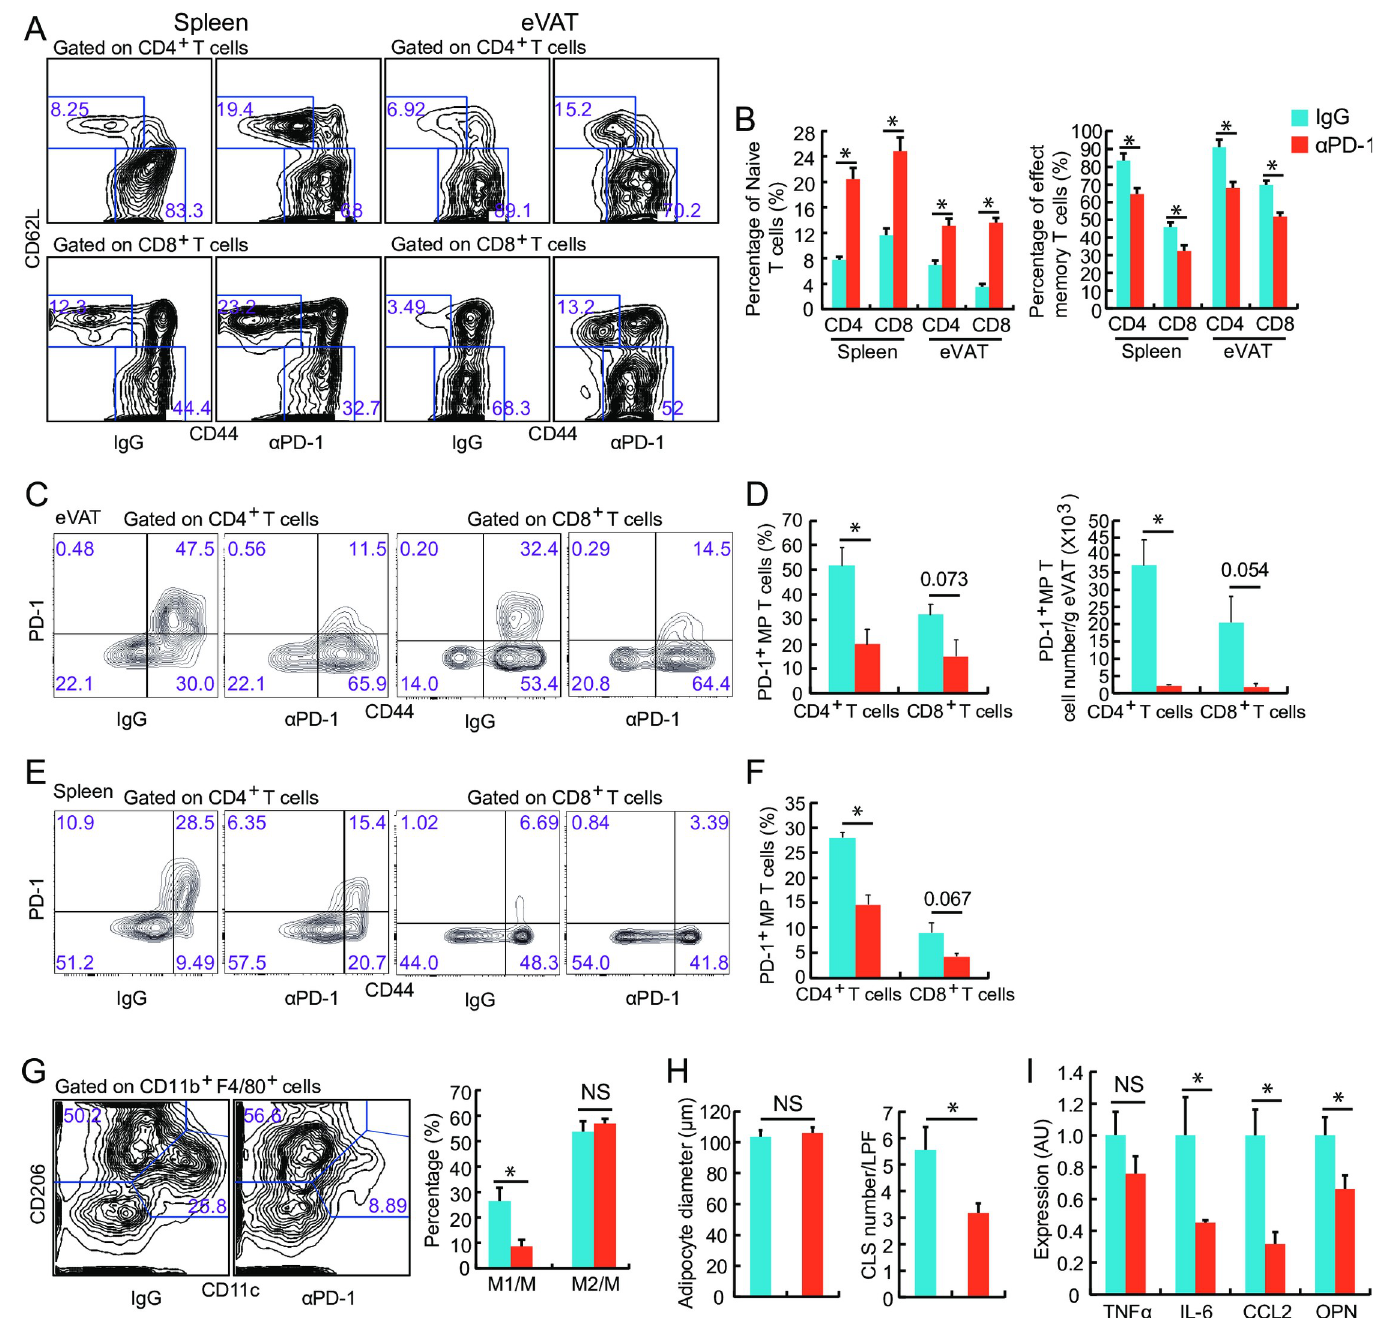
Fig 7. Effects of anti-PD-1 antibody treatment on adipose inflammation in aged mice. Either anti-mouse PD-1 antibody ( α PD-1) or control IgG (IgG) was administered three times per week for three weeks to 77-week-old mice. All examinations were performed when mice reached 80 weeks of age ( n = 4–8 mice in each group). ( A ) Flow cytometric analysis of CD44 - CD62L + T cells (na ï ve T cells) and CD44 + CD62L - T cells (MP T cells) was performed using spleen cells or eVAT of AL and CR mice. ( B ) The percentages of CD44 - CD62L + T cells and CD44 + CD62L - T cells. ( C , D ) Flow cytometric analysis of PD-1 + CD44 + T cells (PD-1 + MP T cells) in SVF from eVAT from aged mice treated with either α PD-1 or IgG. ( E , F ) Flow cytometric analysis of PD-1 + CD44 + T cells (PD-1 + MP T cells) was performed using spleen cells from aged mice treated with either IgG or α PD-1. ( G ) Flow cytometric analysis of M1 type macrophages (CD11b + F4/80 + CD11c + CD206 - ) and M2 type macrophages (CD11b + F4/80 + CD11c - CD206 + ) in eVAT from aged mice treated with either α PD-1 or IgG. ( H ) Mean adipocyte diameter and the number of CLS in eVAT. ( I ) Real- time PCR analysis of cytokine expression in eVAT. The expression levels of each transcript were normalized to those in aged mice treated with IgG ( n = 6–8 mice in each group). AU: arbitrary units. � P < 0.05; NS: not significant. Data are represented as the mean ± SEM.